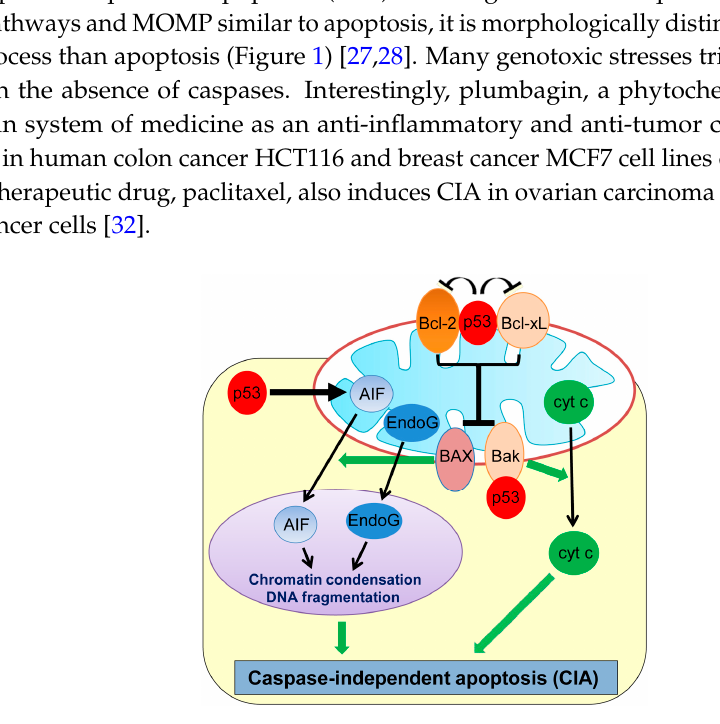
Figure 1. Schematic representation of caspase-independent apoptosis (CIA) and its regulation by p53. p53 transcriptionally upregulates AIF, binds and inhibits Bcl-2 and Bcl-xL, and also binds with Bak to induce CIA. AIF: Apoptosis-inducing factor; cyt c: cytochrome c; EndoG: endonuclease G.